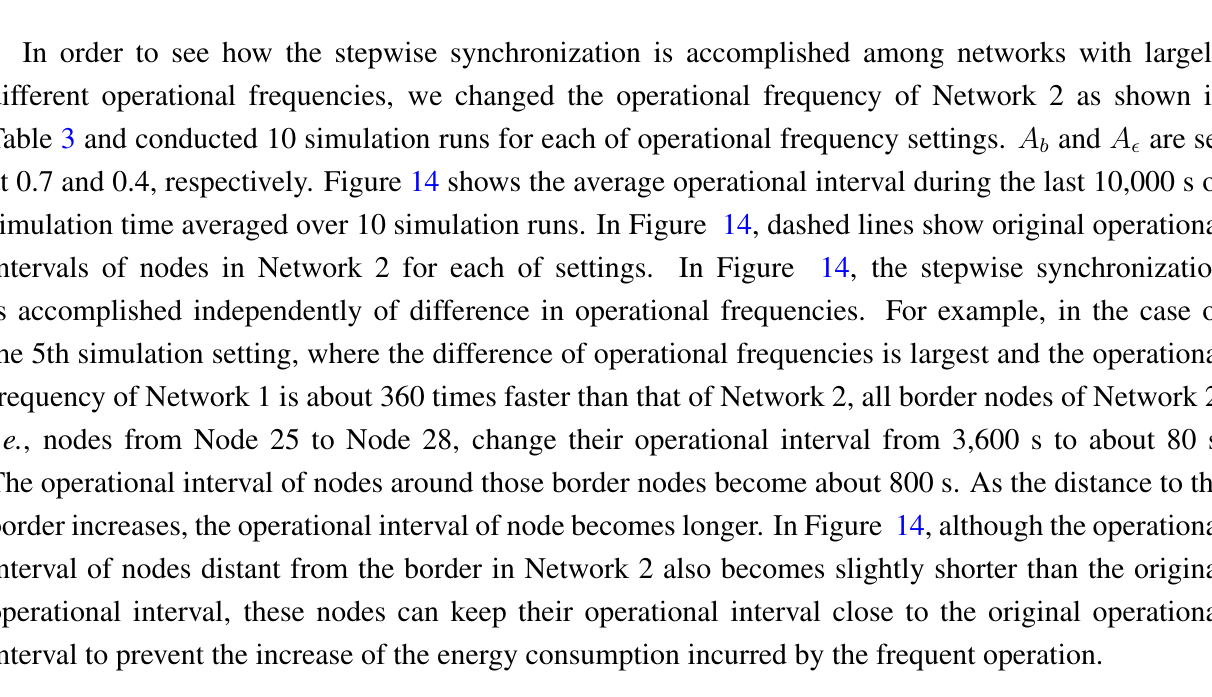
Table 3. Operational frequency settings.